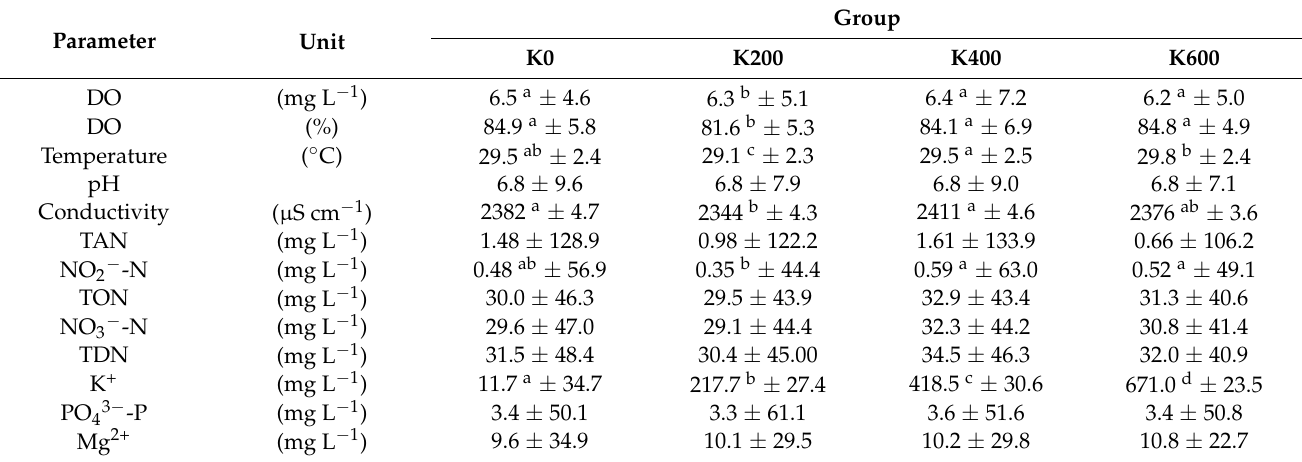
Table 1. Physicochemical water parameters (mean ± CV).